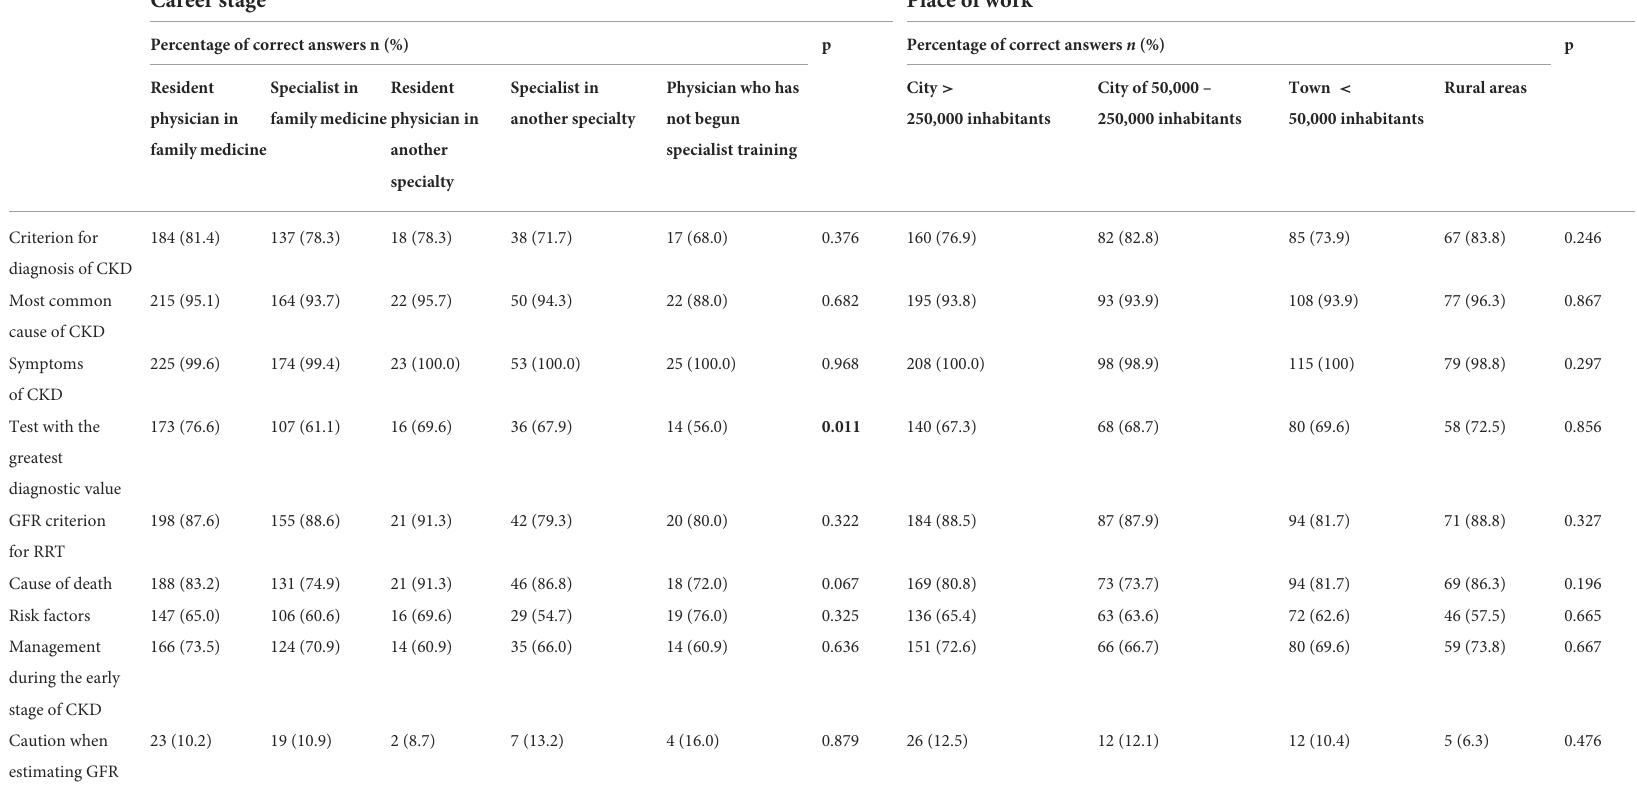
TABLE 4 The comparison of individual questions according to career stage and place of